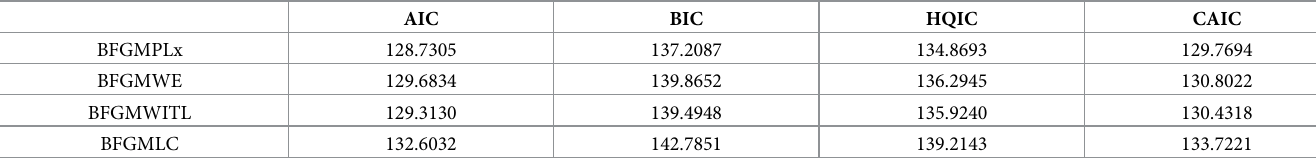
Table 7. AIC, BIC, HQIC, and CAIC for bivariate models.